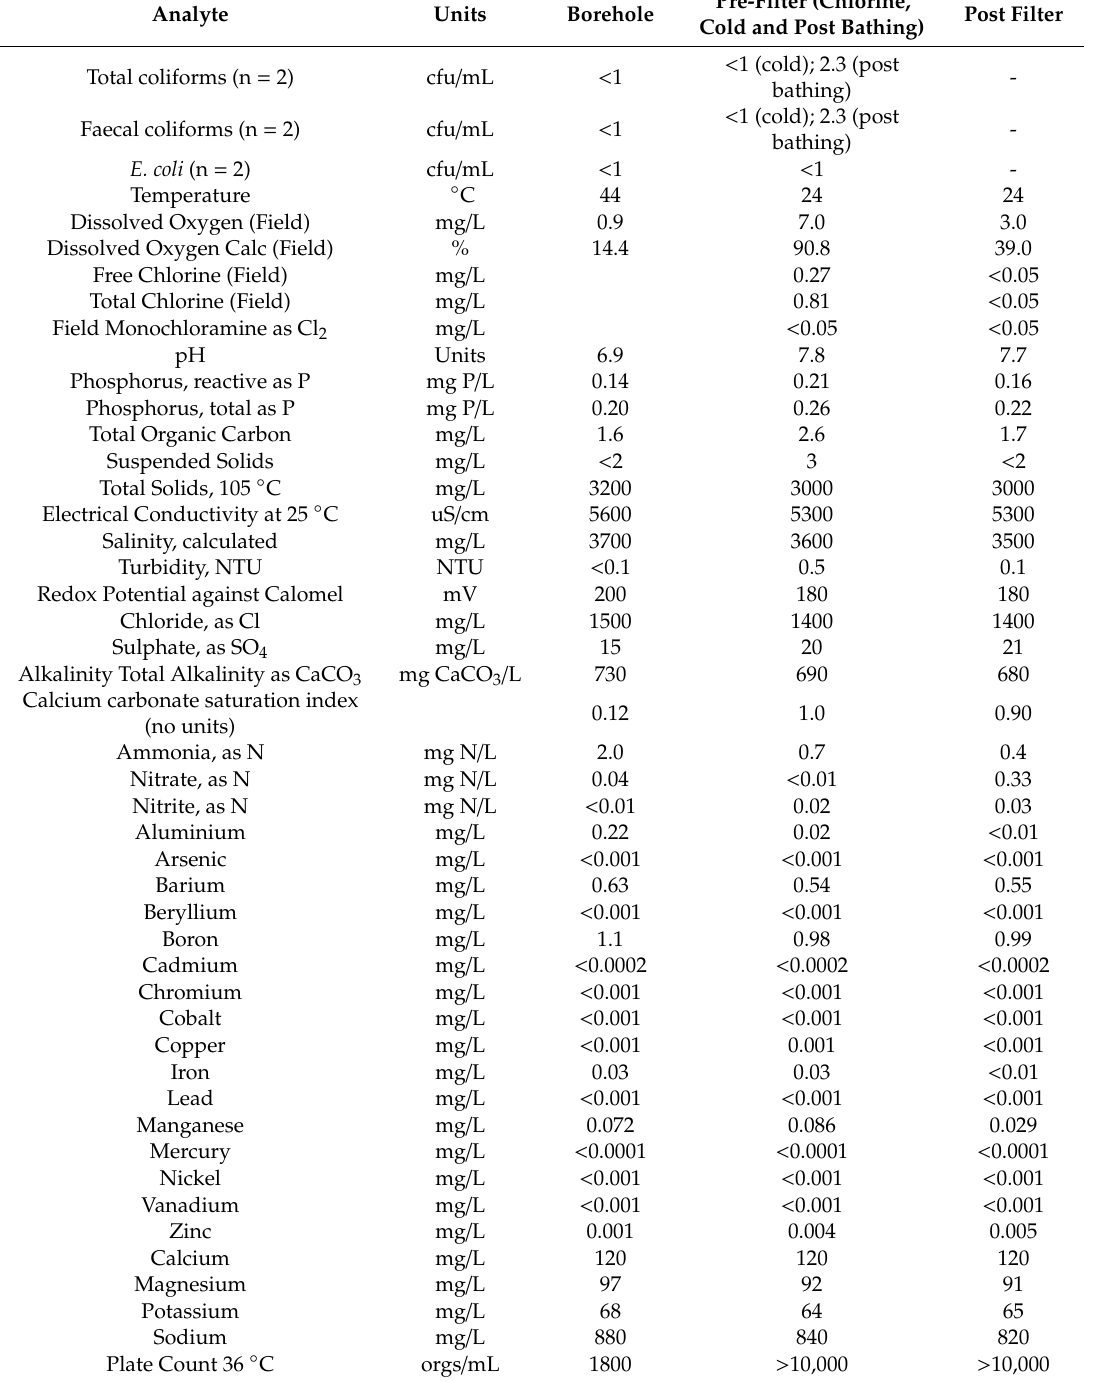
Table 1. Physicochemical data measured at Peninsula hot springs from the borehole, pre- and post-filter.